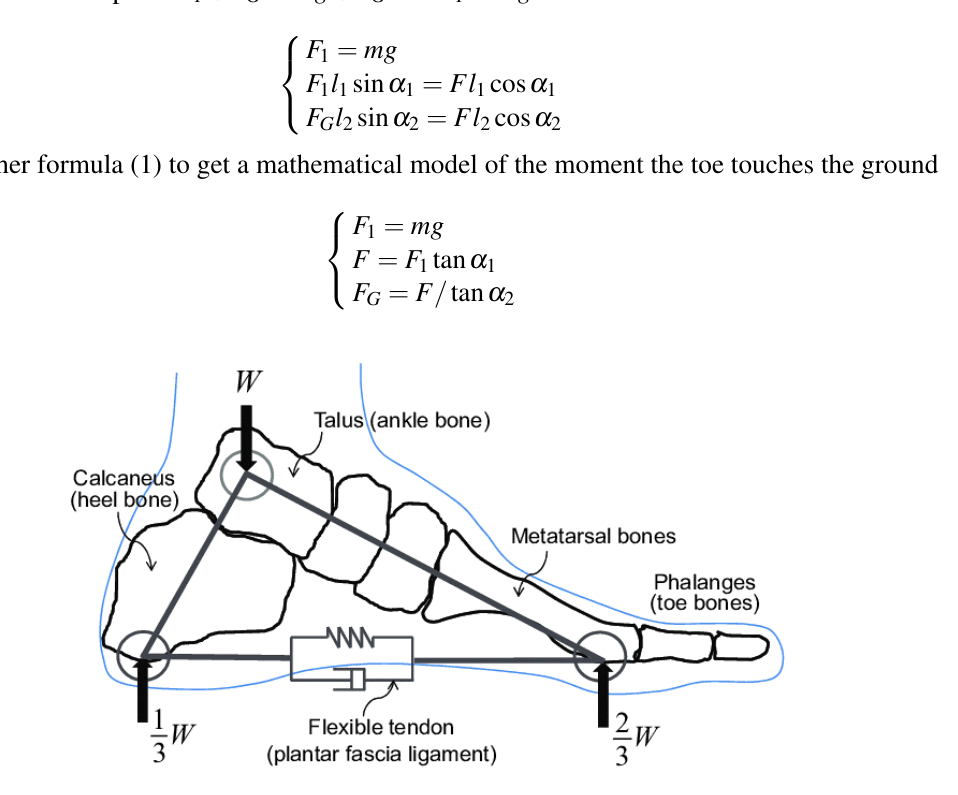
Fig. 1 Schematic diagram of the human body landing from the toe touching the ground to the foot lying